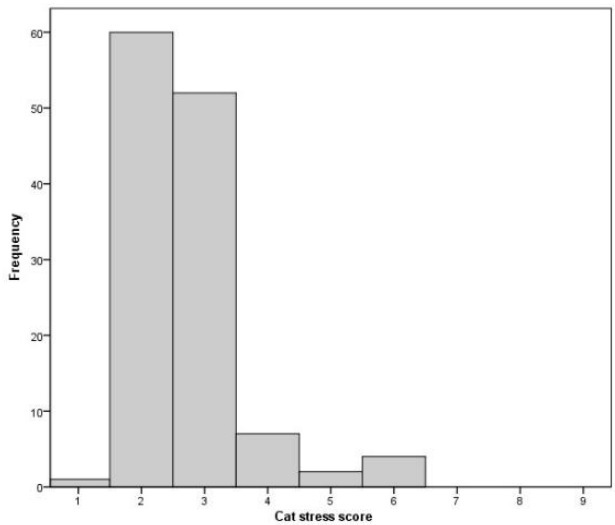
Figure 2. Histogram showing the frequency distribution of the average cat stress score for each cat with useable CSS data, taken from three measures per visit ( n = 126).